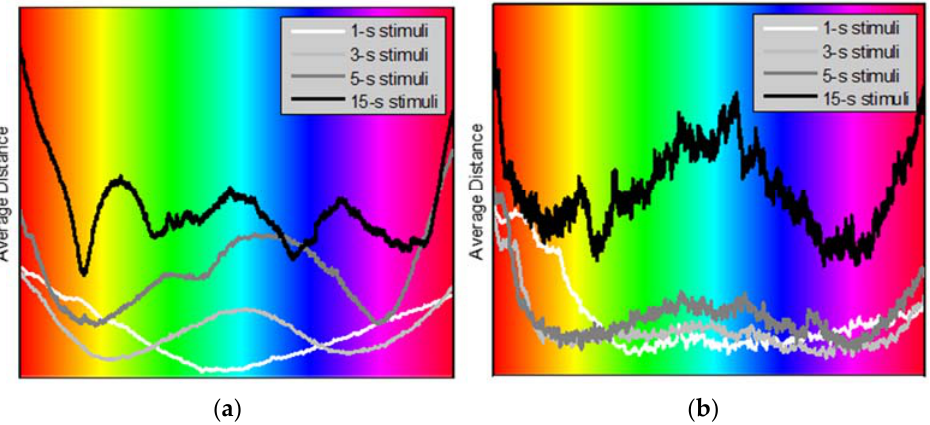
Figure 7. Average distance evaluated for male ( a ) and female ( b ) participants and for all EEG channels as a function of stimulation color.